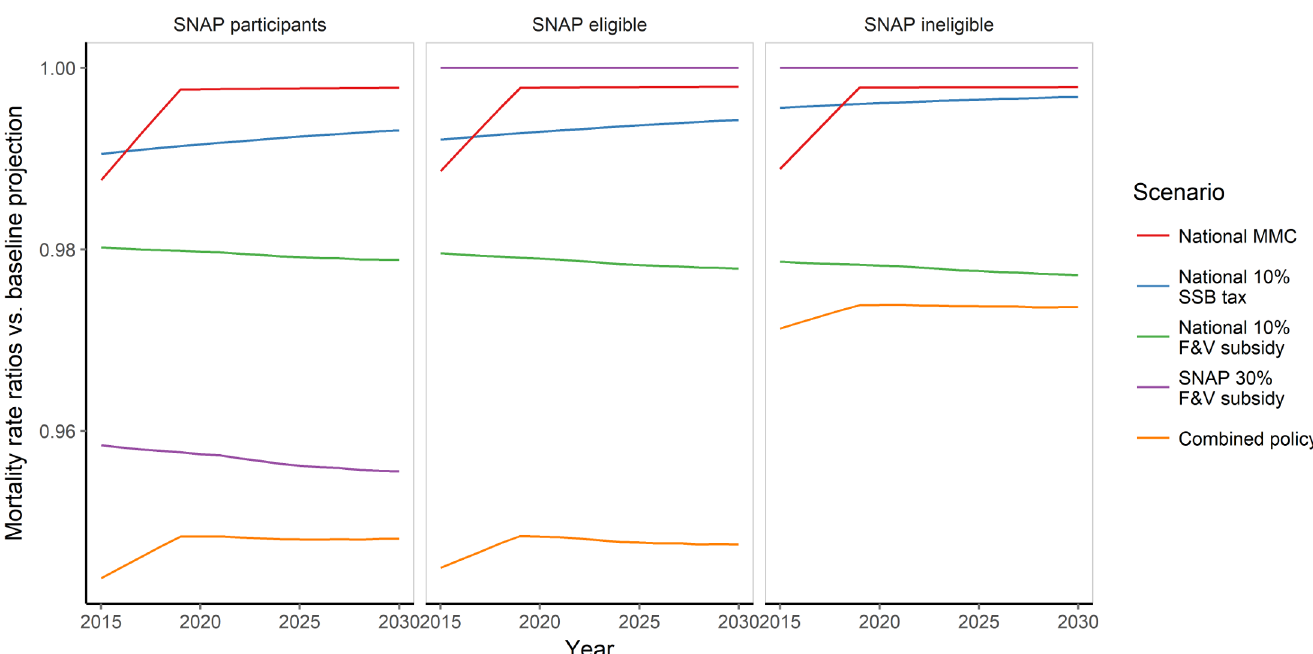
Fig 4. Standardised cardiovasculardisease mortality rate ratio of each policy scenario versus baseline projection (reference) from 2015 to 2030 by SNAP group. Mortality rate ratio demonstrates mortality rate in 2030 under each given policy scenarioversus baselineprojectionmortality rate. F&V, fruit and vegetable; MMC, mass media campaign;SNAP, Supplemental NutritionAssistance Program; SSB, sugar-sweetened beverage.